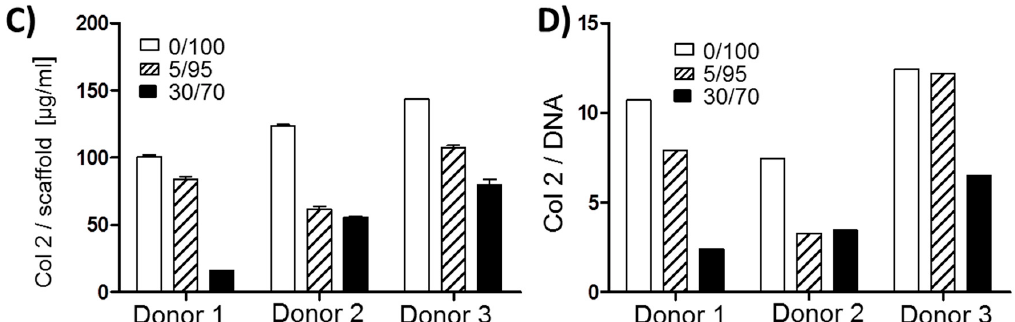
Figure 2. ( A ) Resazurin staining for viability of seeded MSCs; 5 scaffolds per donor and 3 donors per time point were evaluated; ( B ) DNA content of different scaffolds at day 1 and 21 shows no significant difference between scaffolds at the same time points (# p < 0.05 for all groups compared to day 21), 3 different donors per time point were evaluated; ( C ) Collagen 2 content per scaffold (µg/mL), primary hMSCs of three donors were analyzed at day 21; ( D ) Ratio of collagen 2 content per DNA, with higher ratios suggesting better chondrogenic differentiation. Primary hMSCs of three donors were analyzed at day 21.